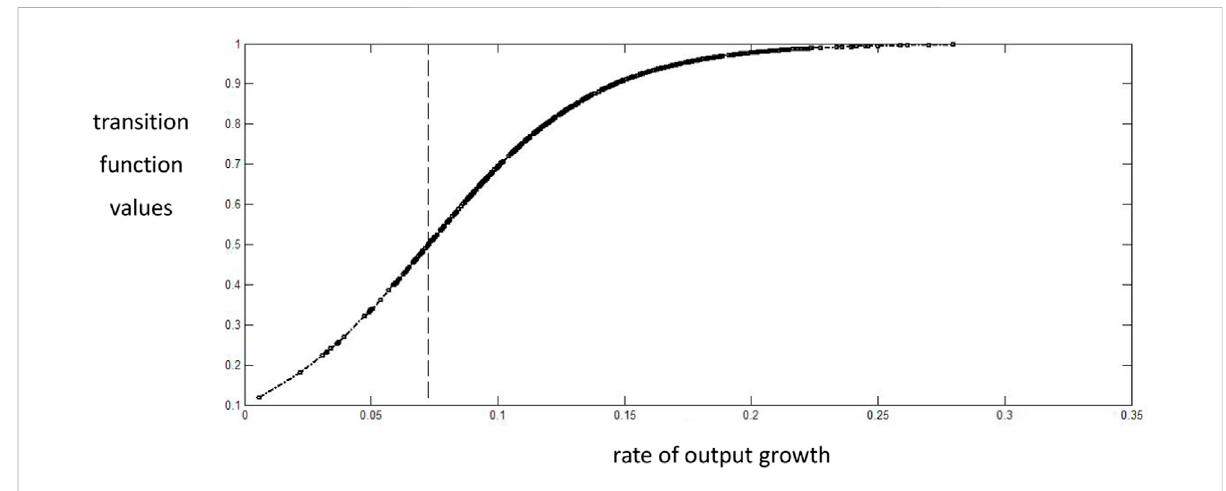
FIGURE 2 The scatter graph of the estimated transition function in the output growth